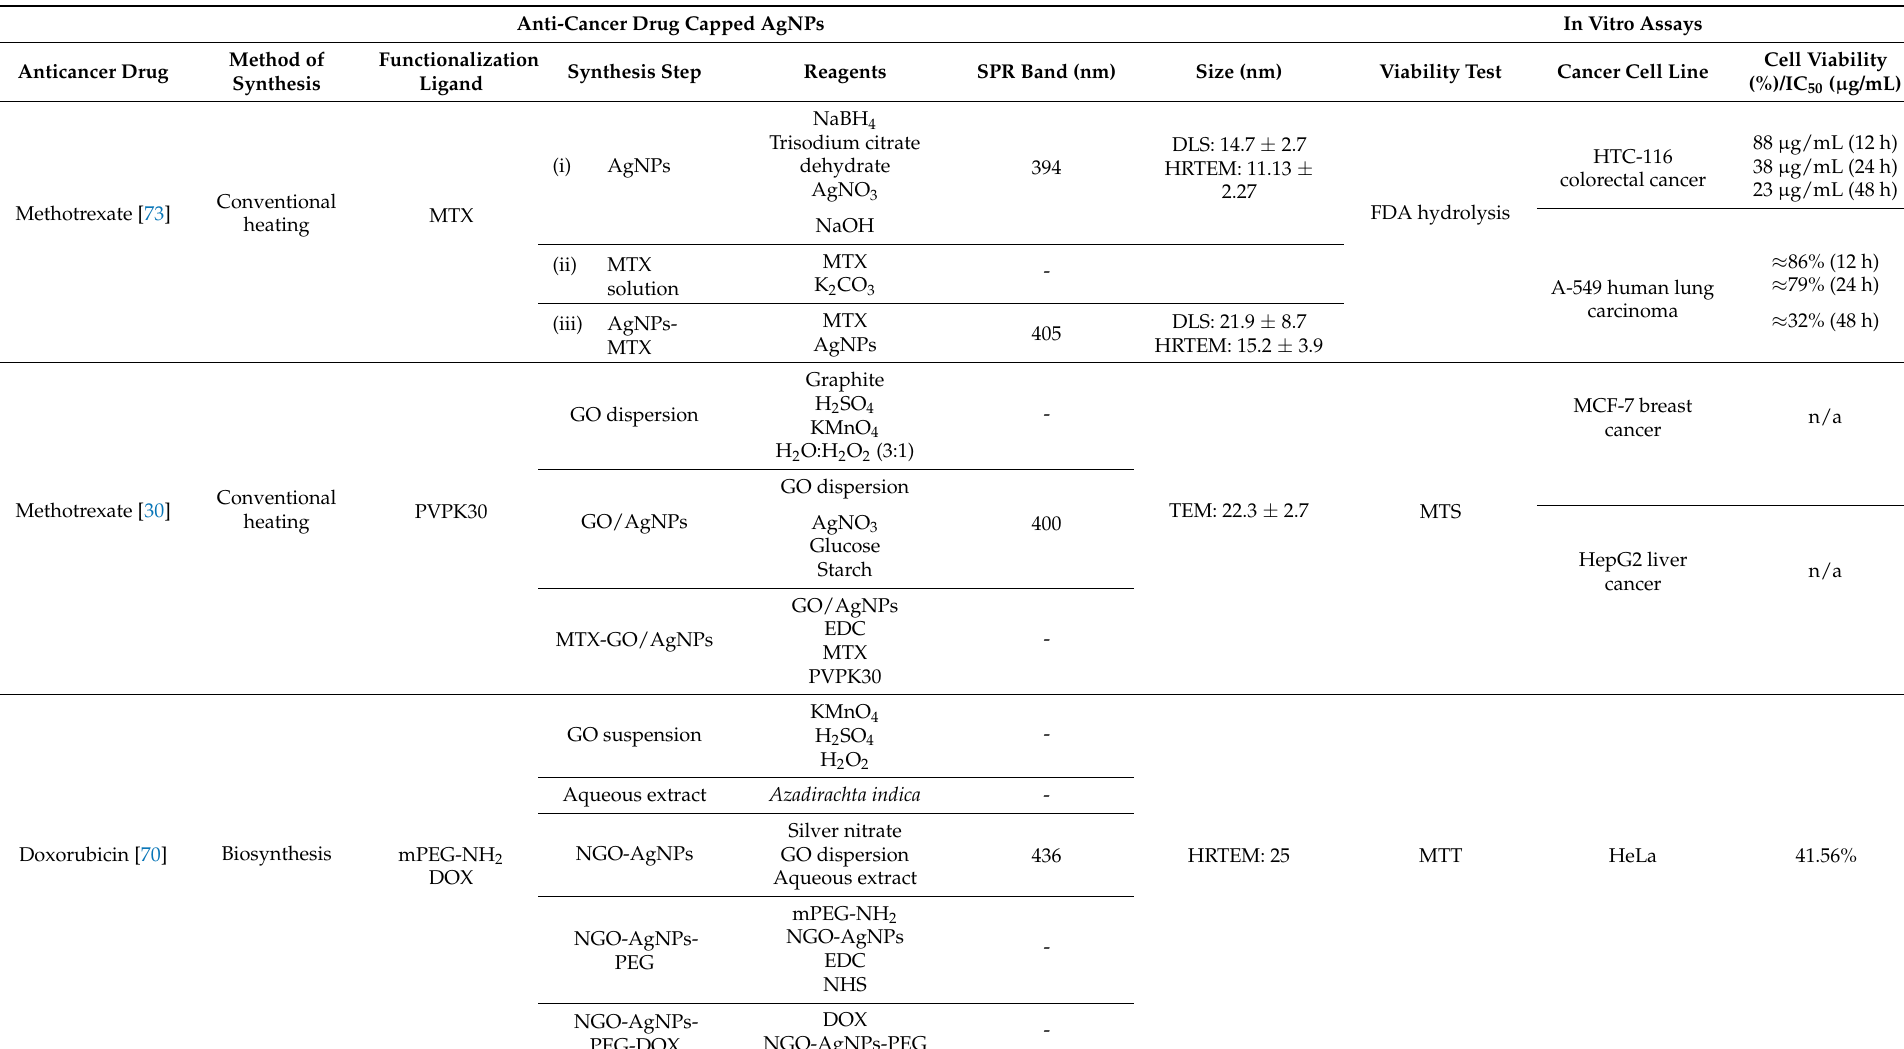
Table 1. Anticancer drugs coupled silver nanoparticles main physicochemical characteristics and their cytotoxic effects in in vitro cancer